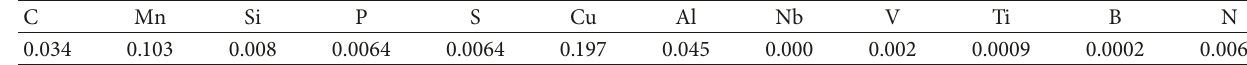
Table 1: Elemental composition of mild Steel (wt.%).